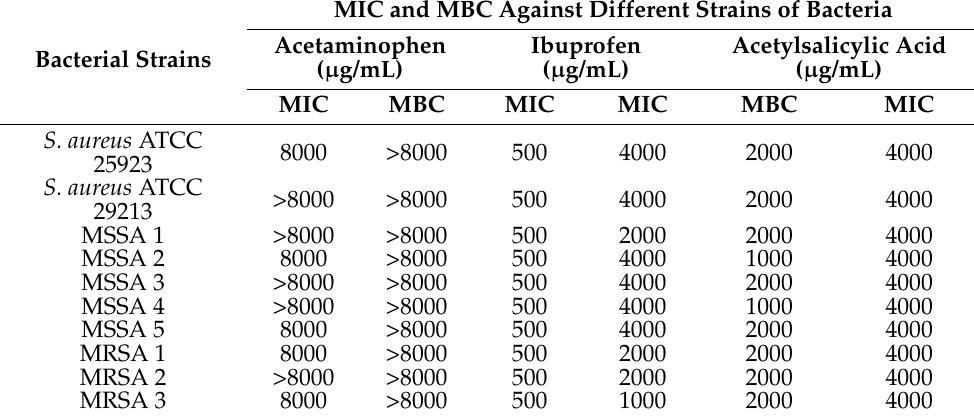
Table 1. Antimicrobial activity of antipyretics against different strains of S. aureus.